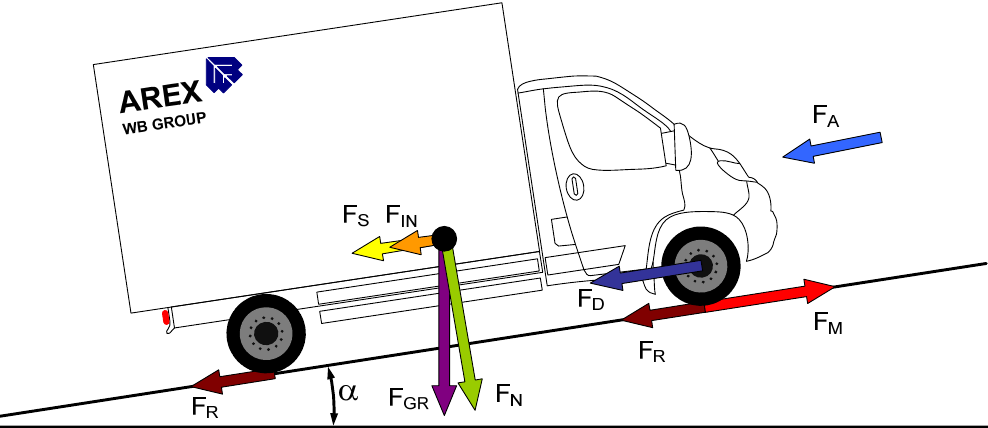
Figure 2. Forces acting on a moving eLCV.